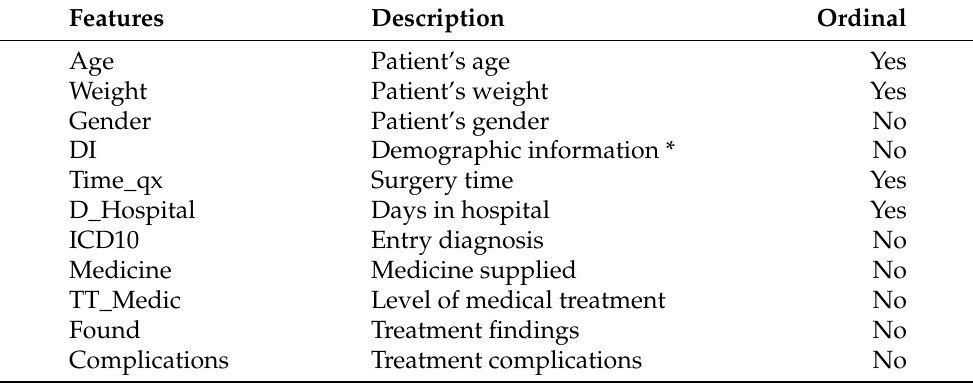
Table 2. Eleven data features employed to describe the present state of patient